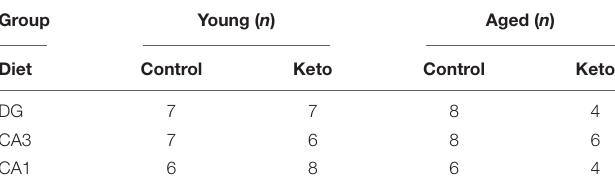
TABLE 1 | Final group sizes for PCR gene